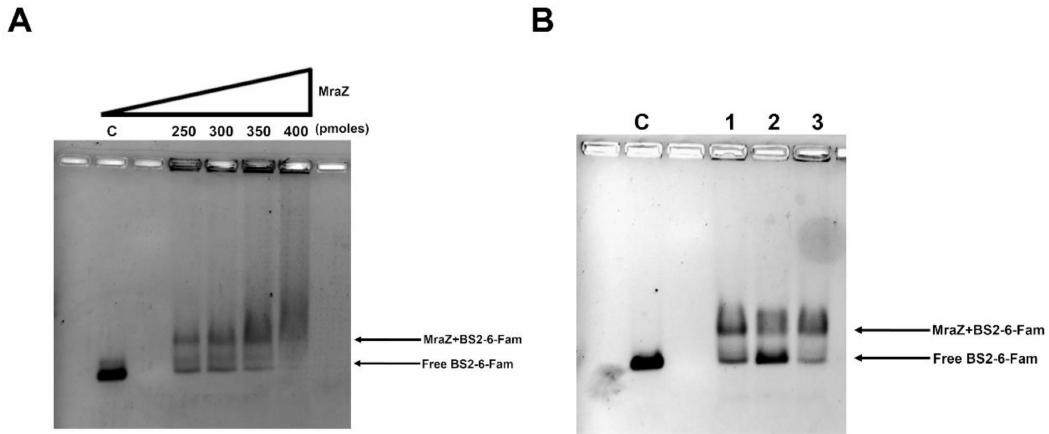
Figure 4. Electrophoretic mobility shift assay of the MraZ protein. ( A ) The gel represents the band shift using a constant BS2-6-Fam DNA amount (C, 0.34 pmoles) and increasing quantities of MraZ. ( B ) Demonstration of the specificity of the binding of MraZ to the fragment BS2, using a fixed amount of protein (300 pmoles) and BS2-6-Fam (0.34 pmoles) (lane 1), a 20 × excess of non-labeled BS2 fragment which competes for the binding of MraZ (lane 2), or a 20 × concentration of non-specific, non-labeled competitor (a 250 bp cepI fragment) (lane